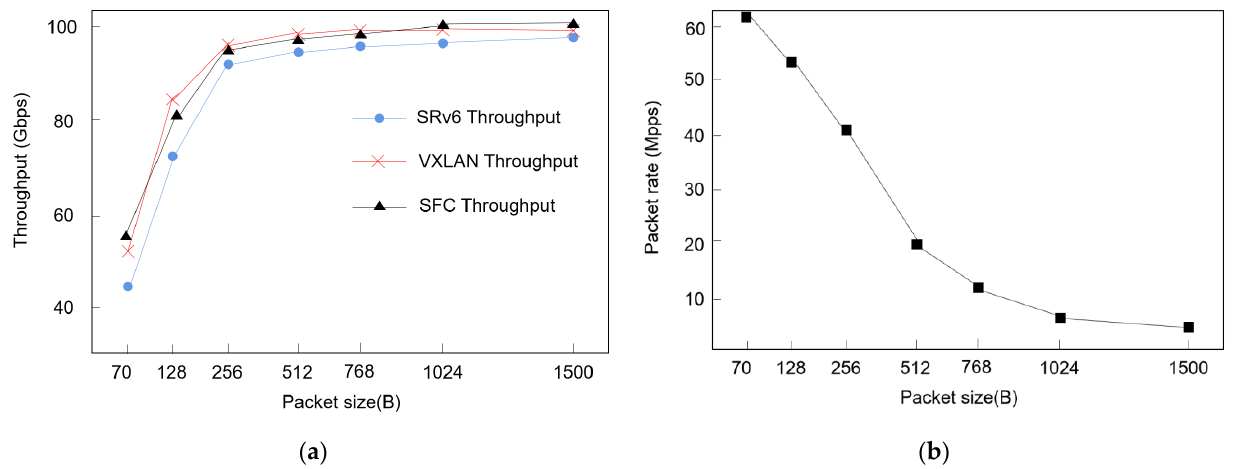
Figure 6. Results for performance. ( a ) Throughput of the SRv6 processor; ( b ) packet rate of the SRv6 processor.